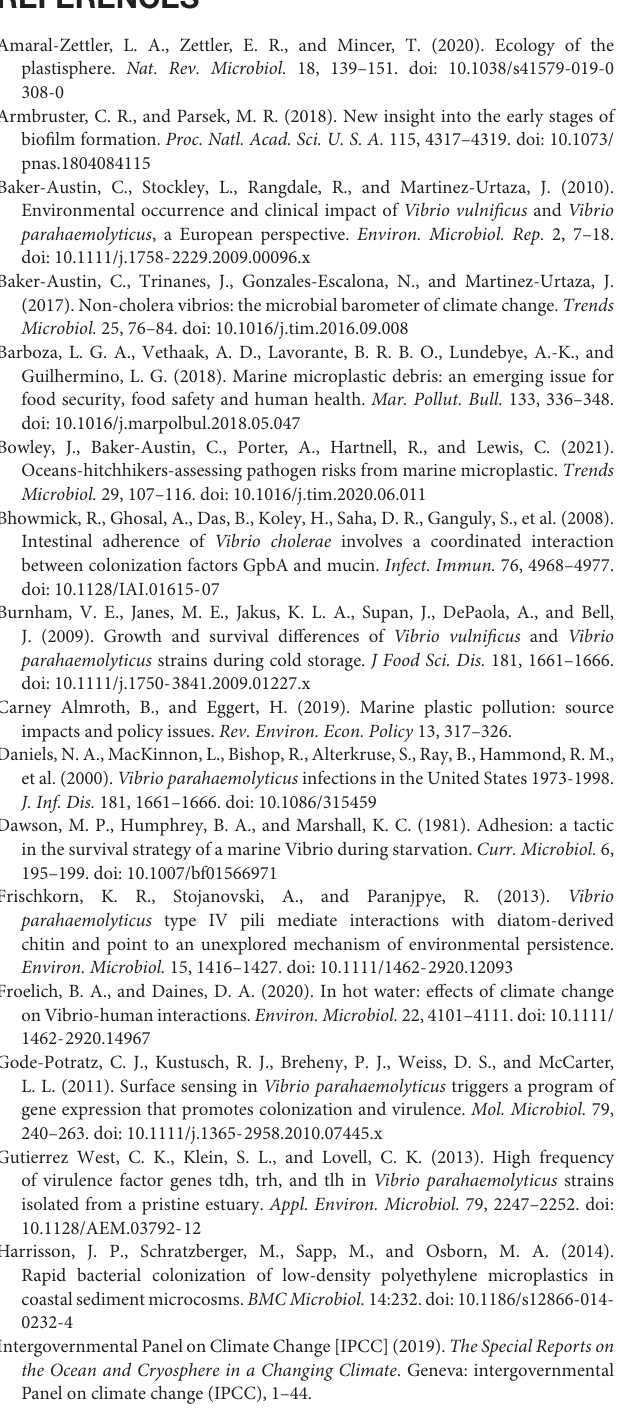
Supplementary Figure 5 | OpaR (A) and Tox R (B) expression in free-living Vp maintained in FSW at 27 and 31 ◦ C. Supplementary Table 1 | Primers and sequences used in this